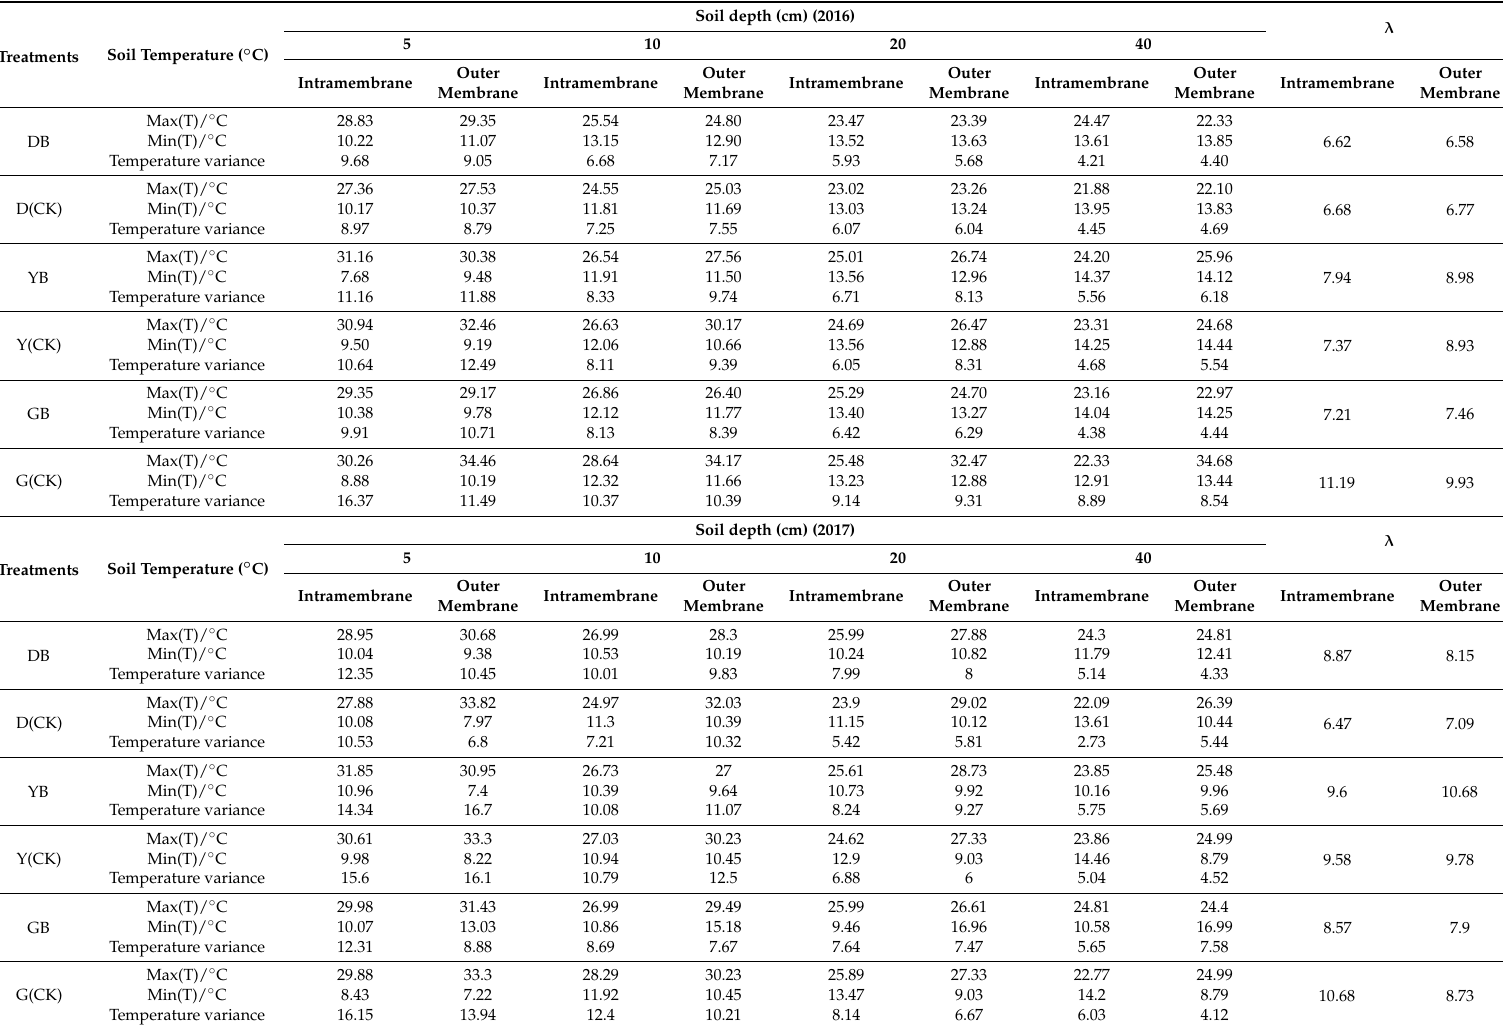
Table 2. Temperature difference coefficient of different